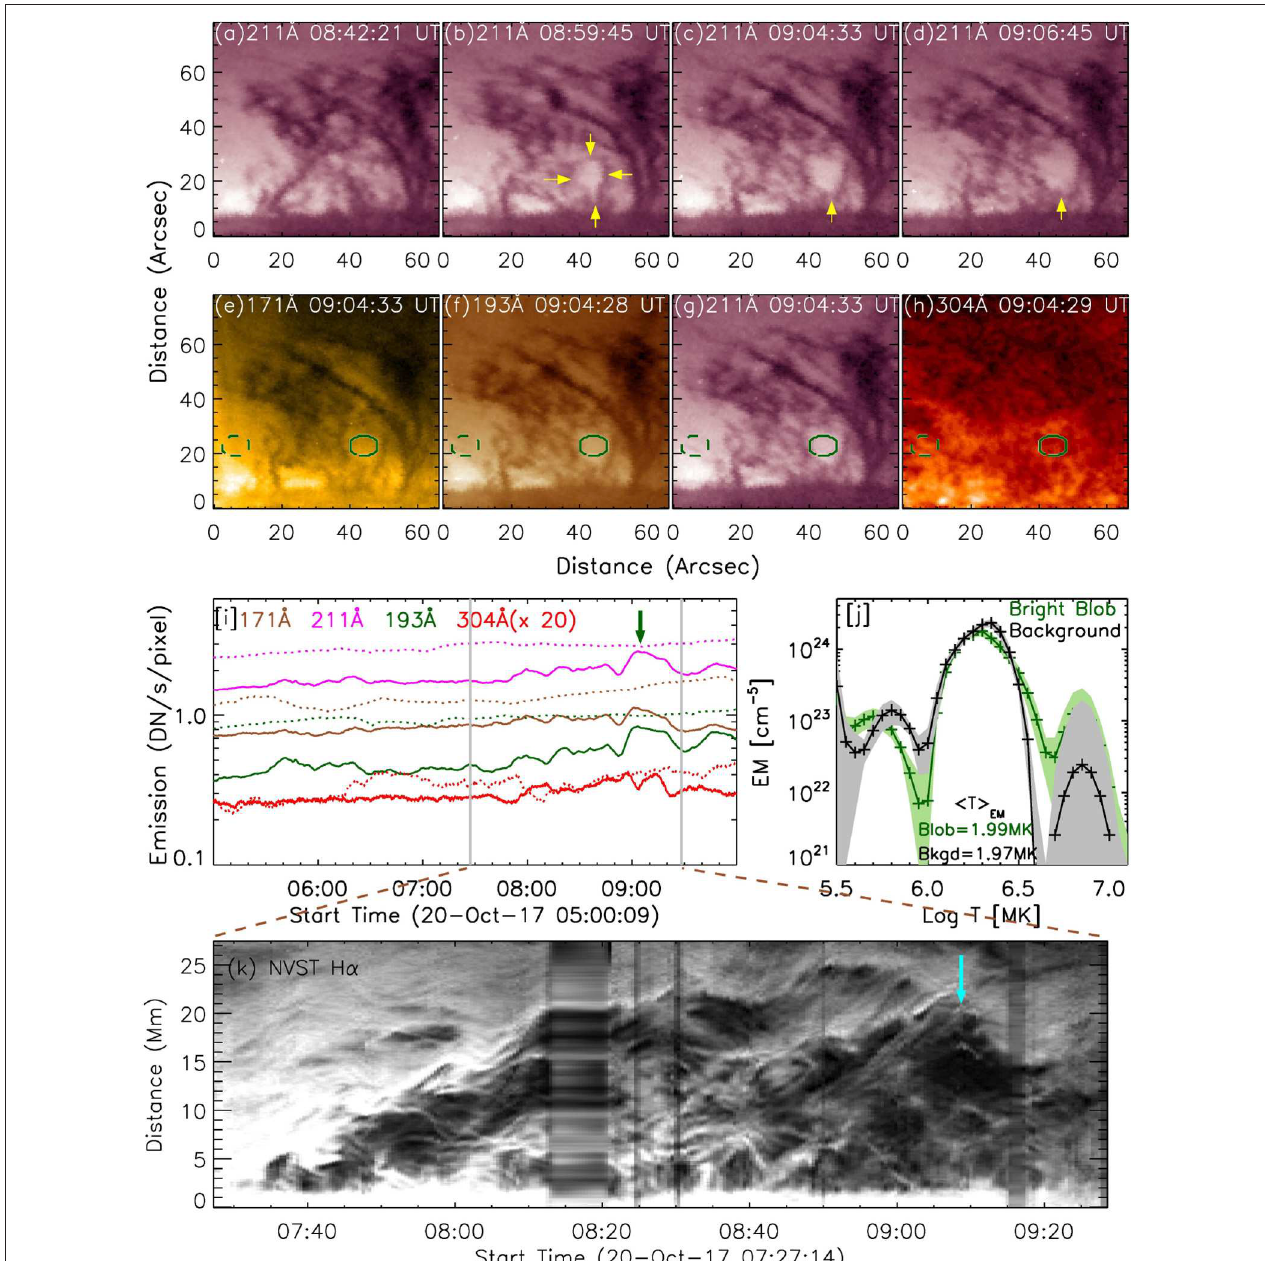
FIGURE 5 | EUV perspective of the prominence bubble and thermodynamical evolution of a bright blob within the bubble. (a–d) Similar to the H α observations, the bubble interior appears highly structured throughout its evolution. The formation and expansion of an interesting bright blob-like feature within the bubble, indicated by yellow color arrows in the top panel of the figure. (e–h) EUV images showing the multi-wavelength perspective of the blob at 09:04 UT. (i) Mean EUV intensity profile within a region-of-interest (ROI) representing the blob (green; full line) during 05:00 UT–10:00 UT. Background intensity evolution in respective wavelengths as derived from a ROI away from the prominence [dotted green region in panels (e–h) ] is also plotted. (j) Emission measure distribution within the selected ROIs corresponding to bright blob (green) and background (black) is plotted along with the respective errors. (k) Time-distance map prepared from the H α line-center image sequence over a virtual slit “S1” along the direction A to B (see Figure 2k